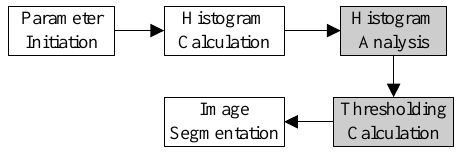
Fig. 2. The flow chart of image